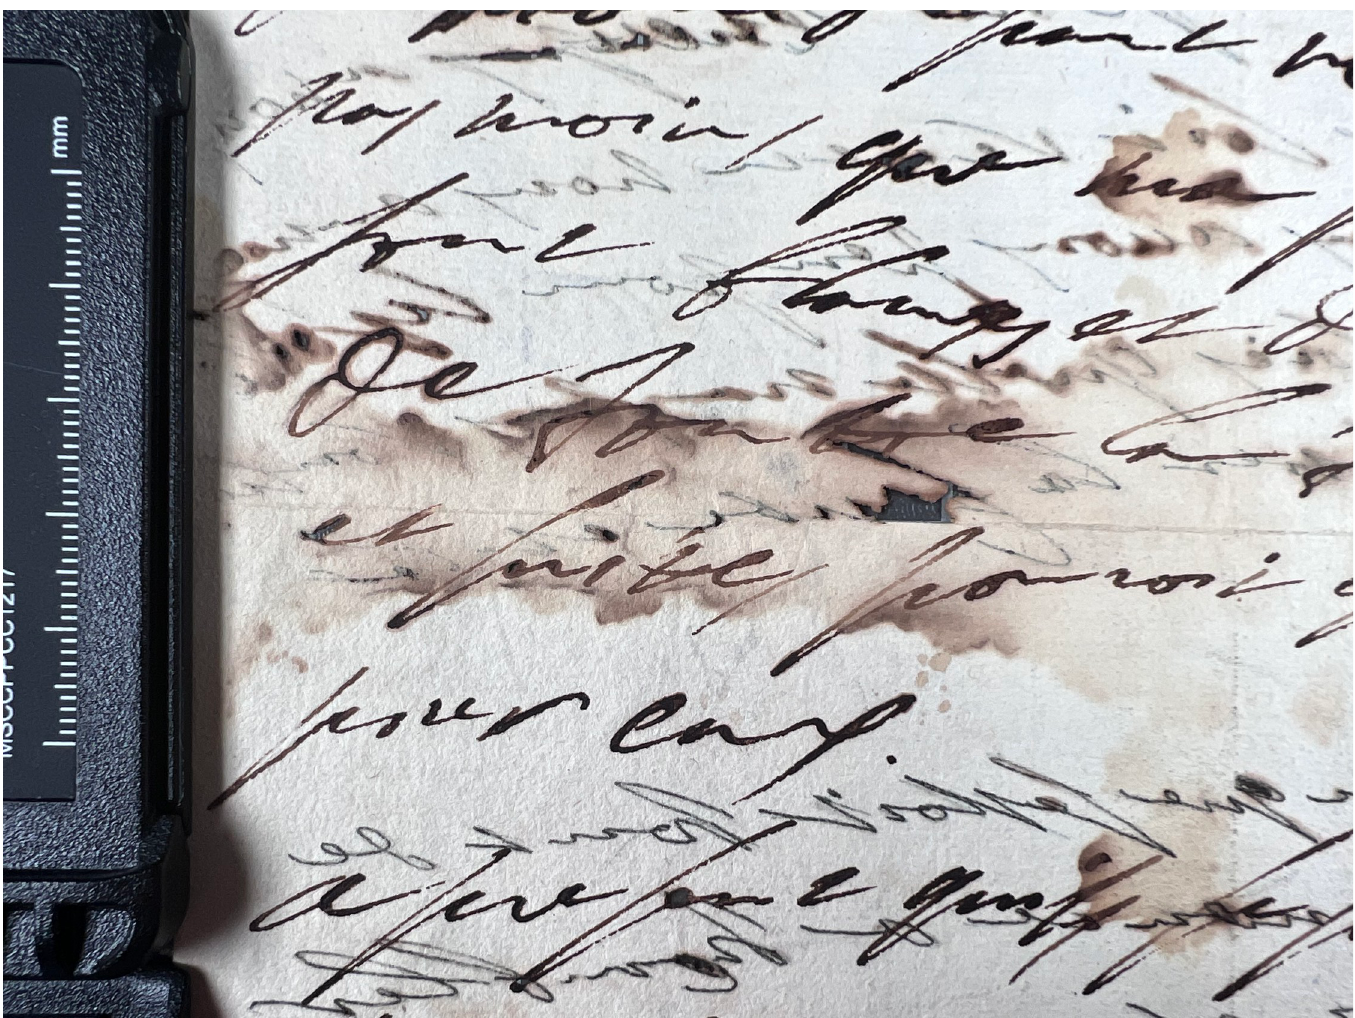
Fig 10. Water damage. Example of documents displaying effects from water damage. This particular document from volume K 400 of the Azzolino collection.